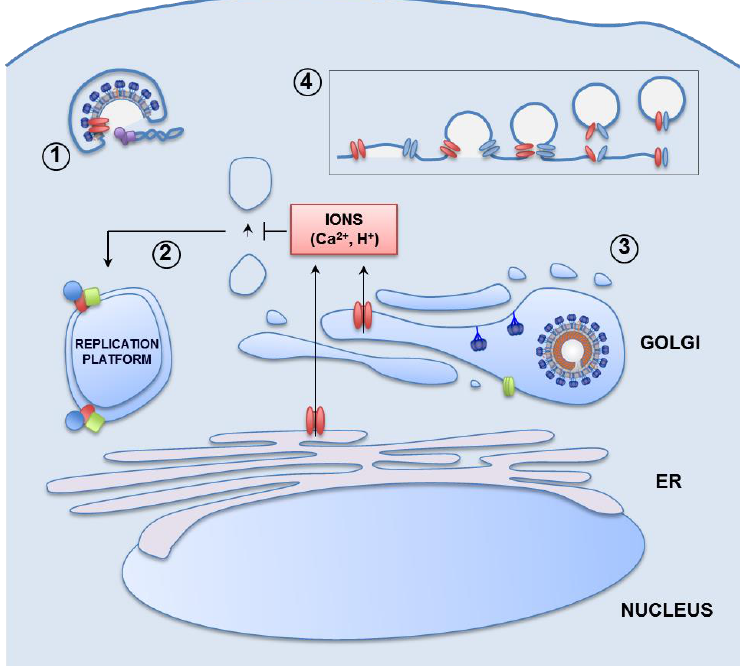
Figure 3. Pathways stimulated by viroporin ion channel activity leading to virus production.